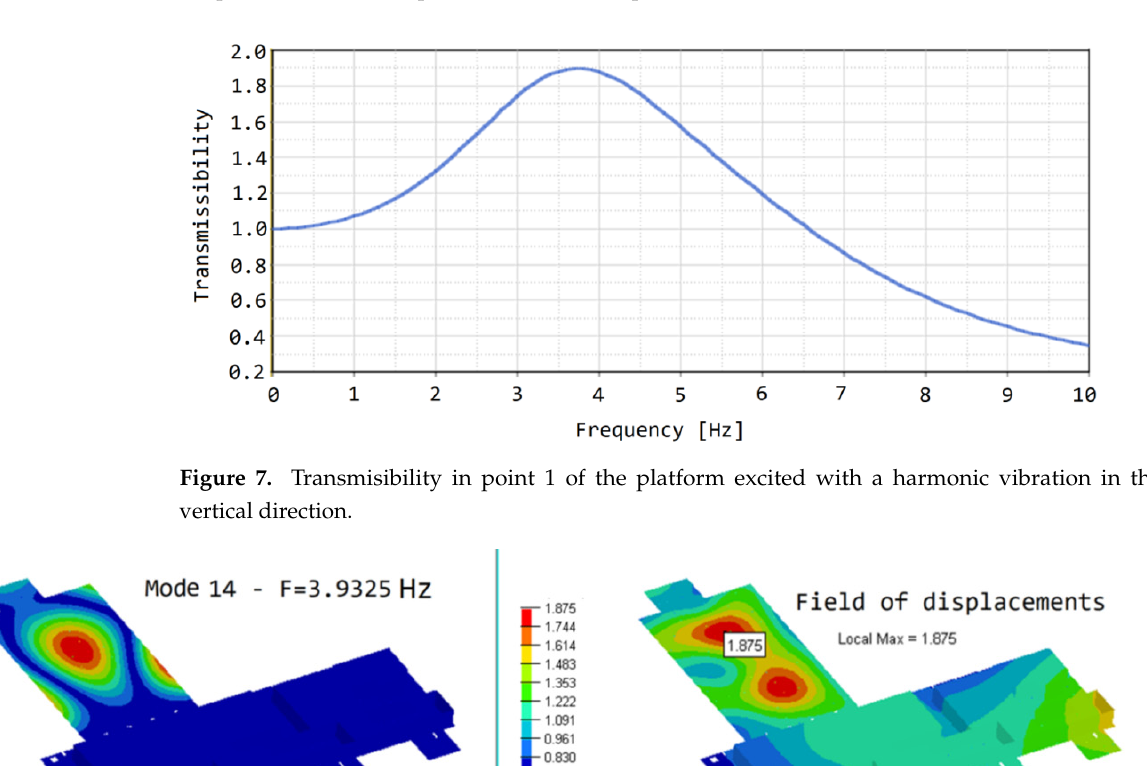
Figure 6. The points chosen to follow the transmissibility of a harmonic vibration. The points 1–7 are the points where the displacements were computed.